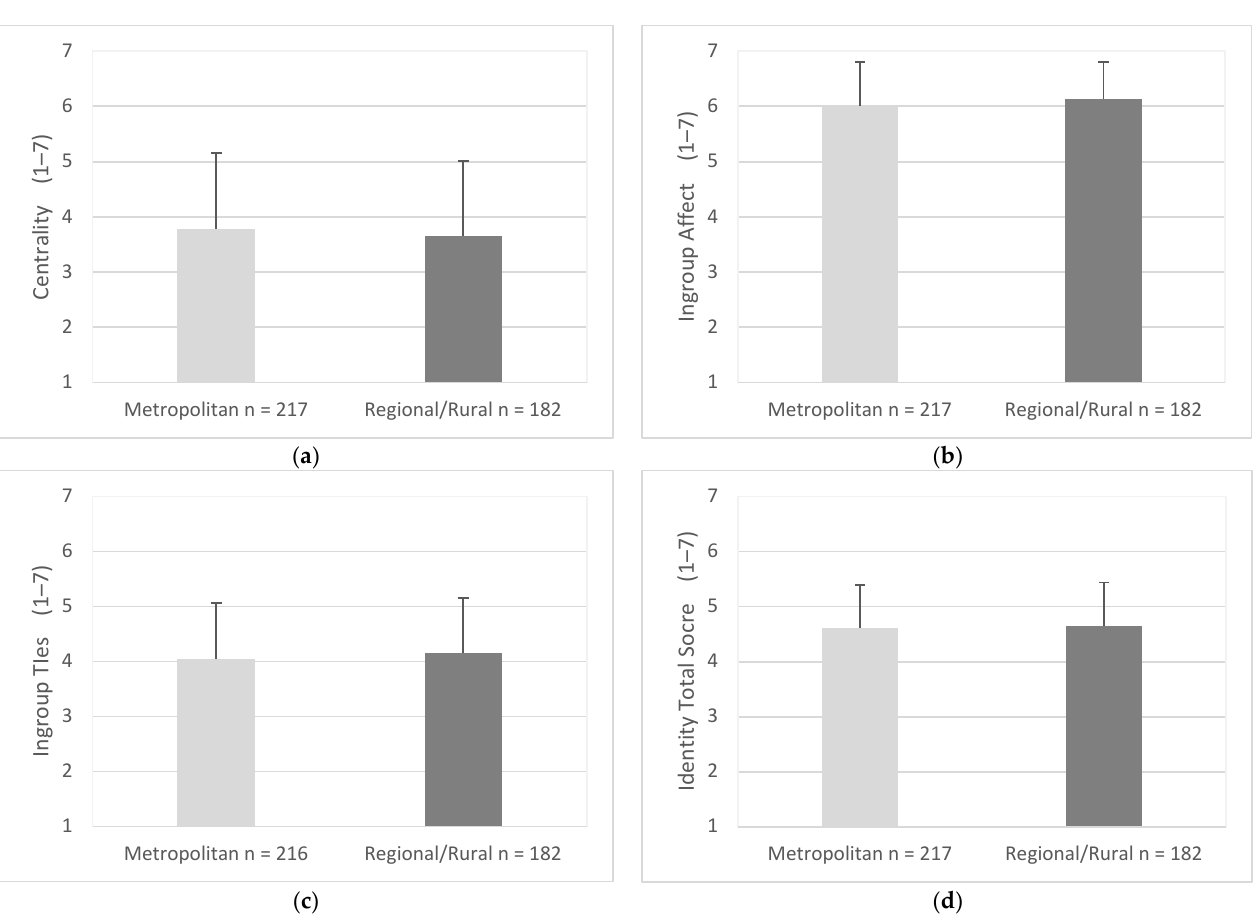
Figure 8. Mean score for identity factors and total scores as endorsed by drivers from metropolitan and regional/rural areas. Items were measured using responses of 1 (strongly disagree) to 7 (strongly agree). Error bars represent standard deviation. ( a ) Centrality, ( b ) Ingroup Affect, ( c ) Ingroup Ties, ( d ) Identity Total Score.